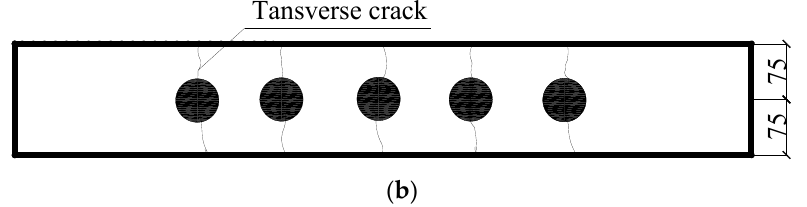
Figure 6. Schematic diagram of sample position for chloride profile (mm). ( a ) Uncracked beam; ( b ) Cracked beam.